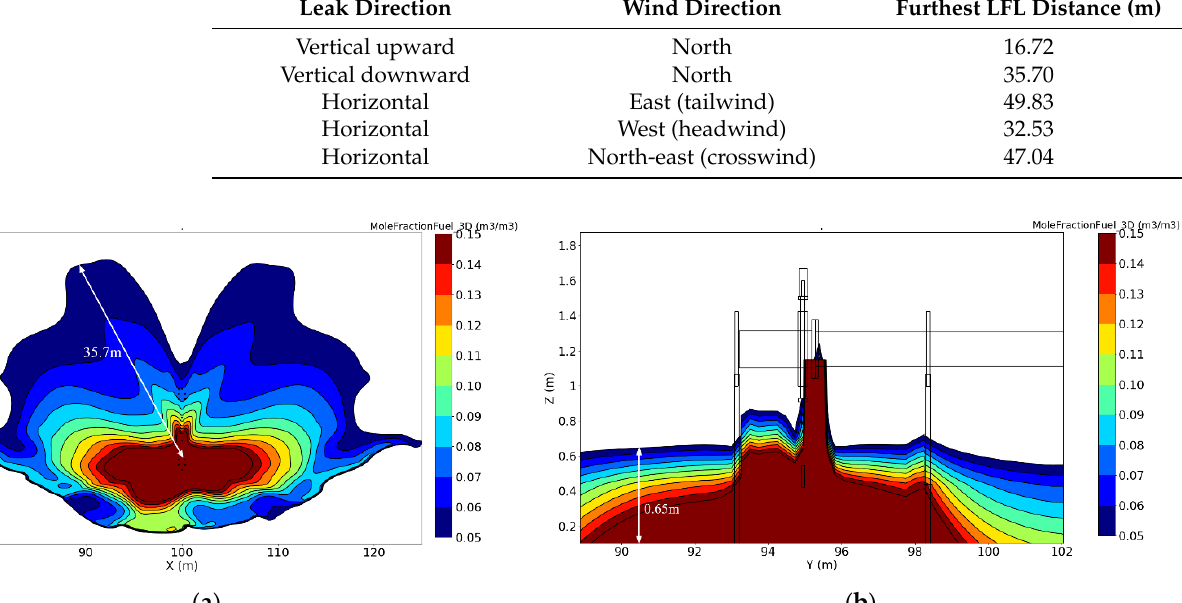
Figure 4. ( a ) Plane view of the downward leak spreading across the ground with LFL distance of 35.7 m; ( b ) section view of the downward leak at the leak source with a height of 0.65 m.